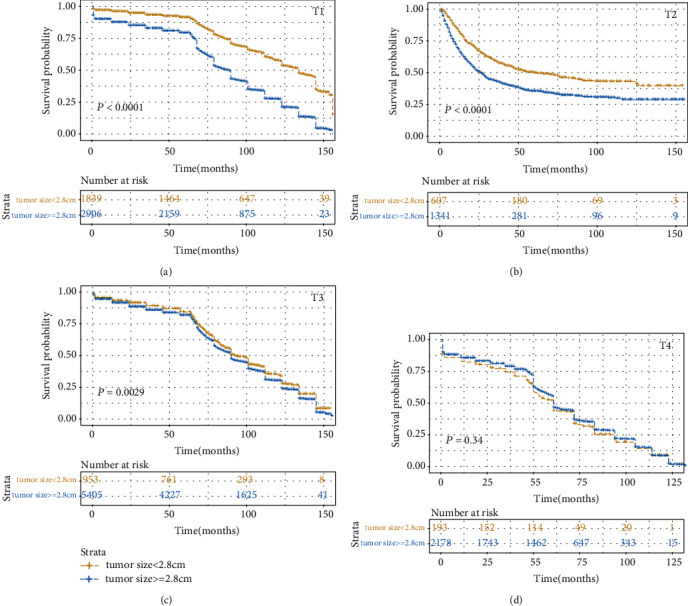
Kaplan-Meier survival curves compared tumor size less than 2.8 cm with tumor greater than or equal to 2.8 cm based on different T stages in the CSS set: (a) in the T1 stage, (b) in the T2 stage, (c) in the T3 stage, and (d) in the T4 stage.